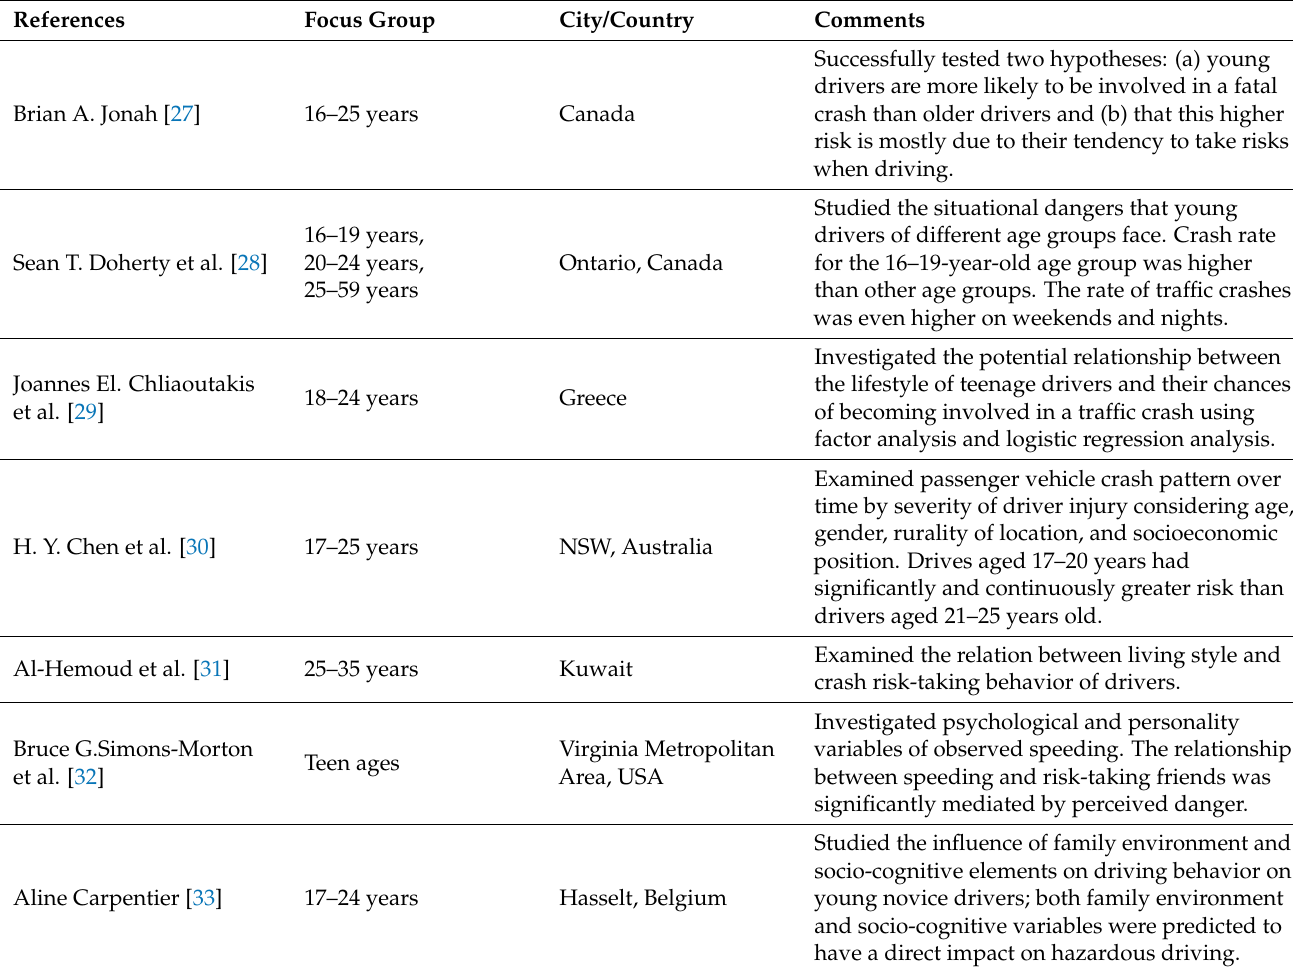
Table 1. Comparative summary of papers on young drivers’